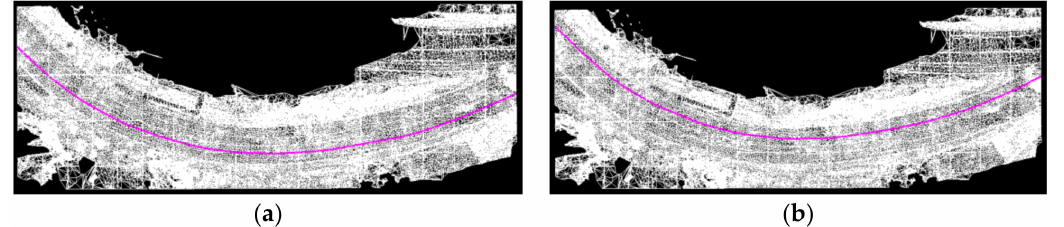
Figure 12. Longitudinal path of the right axis ( a ) and left axis ( b )